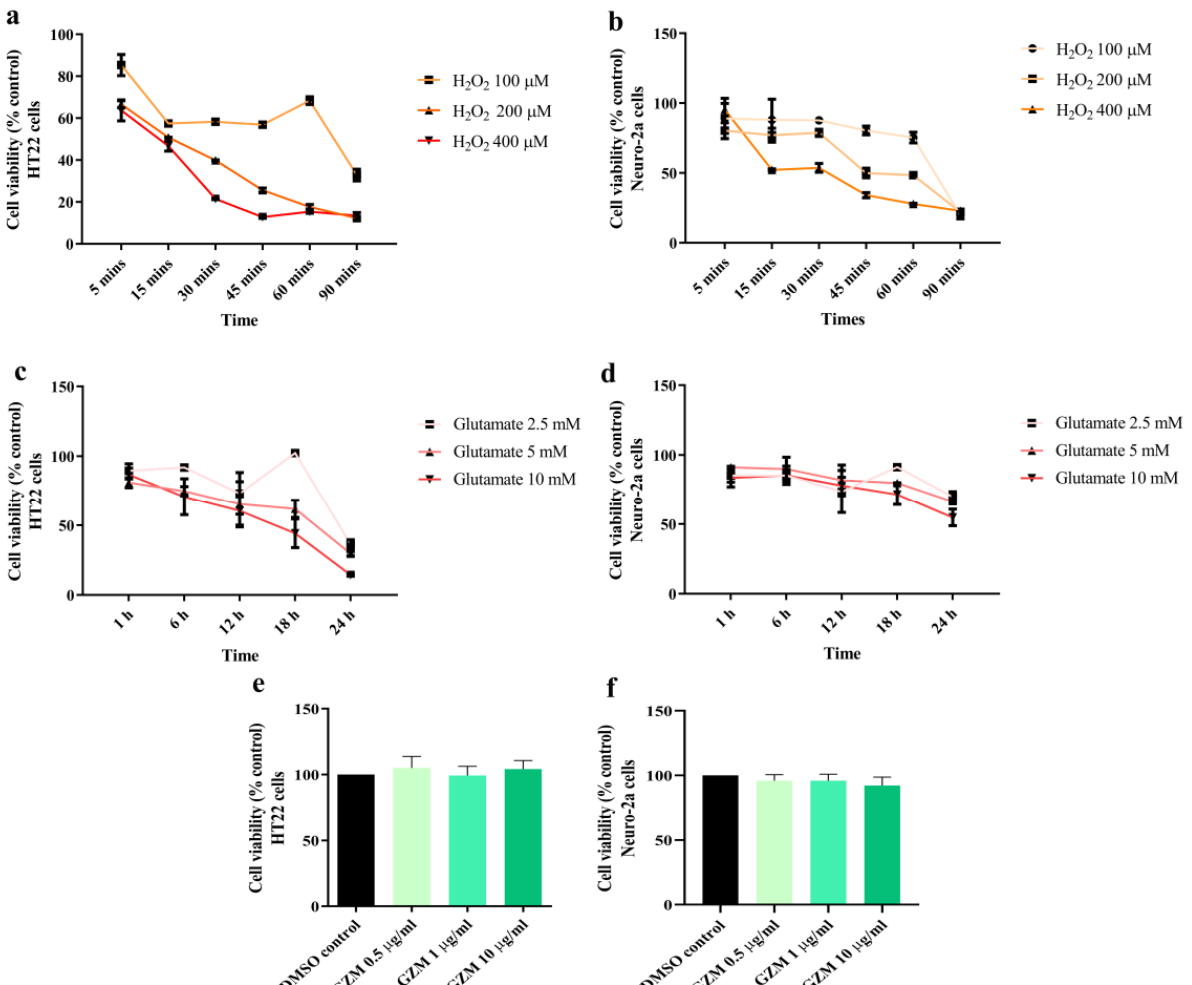
Figure 1. Cytotoxic effects of H 2 O 2 , glutamate, and GZM extract in neuronal (HT-22 and Neuro-2a) cells. Cell viability was analyzed using the MTT method. The neurons were exposed to different doses of H 2 O 2 or glutamate for various time periods in HT-22 ( a , c ) and Neuro-2a cells ( b , d ). The effects of GZM extract on the cell viability of HT-22 ( e ) and Neuro-2a ( f ) cells. The cells were treated with varying concentrations of the extract for 48 h. ( p ≤ 0.001 compared with DMSO control). The details of statistical values are provided in Table S2 (Supplementary Materials).